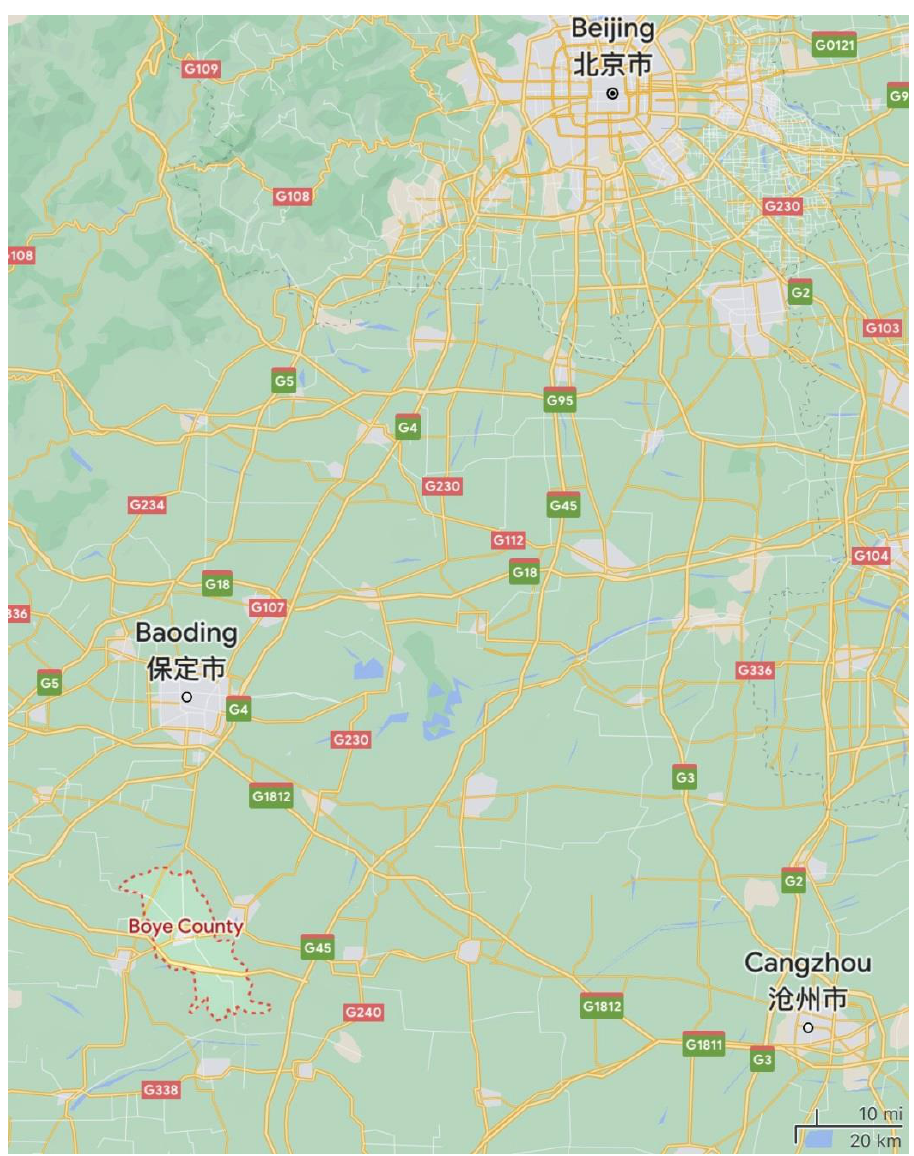
Figure 3. Location of Boye County, Heibei province, China.